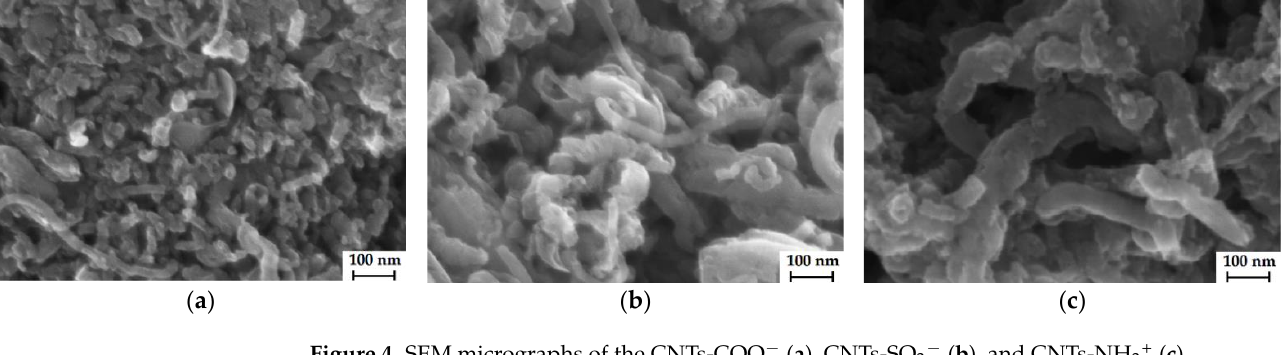
Figure 5. FTIR spectra of CNTs-COO − , CNTs-SO 3 − , and CNTs-NH 3+ . The weak absorption band at 1364 cm −1 was observed in the spectrum of CNTs-COO − due to the О - Н vibrations of the carboxyl group . The absorption bands at 986 and 1178 cm −1 were observed in the spectrum of CNTs-SO 3 − . These bands corresponded to the vi- brations of sulfonic acid groups. The functionalization of CNTs (3-aminopropyl)tri- methoxysilanol groups resulted in the appearance of the bands at 1056 and 899 cm −1 cor- responding to the vibrations of primary amines and 1196 cm − 1- corresponding to the vibra- tions of Si-O groups. Absorption bands in the О - Н stretching region (3700– 3500 cm −1 ) were observed. The sulfonation of CNTs led to a substantial increase in the intensity and width of the stretching O-H bands at 3700 – 3500 cm −1 , which was caused by the appearance of both the -SO 3 H groups and a considerable amount of water molecules upon the hydration of these acid sites. According to the TGA analysis with mass spectroscopy of the gases evolved, functionalizing groups on the CNTs surface are thermally stable up to the tem- perature >200 °C [44,45]. These data support the efficiency of CNTs functionalization by - SO 3 − and - О -Si(OCH 3 ) 2 -(CH 2 ) 3 -NH 3+ groups. The functionalized CNTs were quite suitable as dopants for MF-4SC-type membranes with an operating temperature of <120 °С.